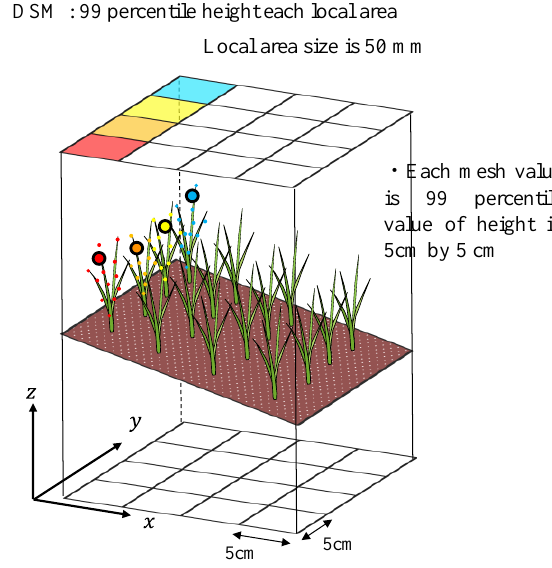
Fig.3 Experimental site and fertilization